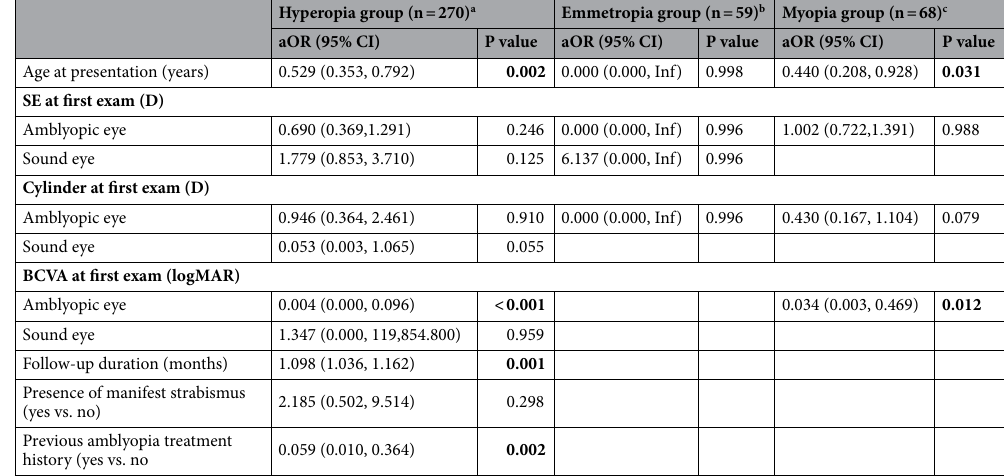
Table 3. Adjusted odds ratio values of factors influencing amblyopia treatment success during follow-up in hyperopia, emmetropia, and myopia groups. aOR adjusted odds ratio, CI confidence interval, D diopter, SE spherical equivalent, BCVA best-corrected visual acuity, Inf infinity. a Multivariate model of the hyperopia group started with age at presentation, SE of amblyopic eye, SE of sound eye, cylinder of amblyopic eye, cylinder of sound eye, logMAR BCVA of amblyopic eye, and logMAR BCVA of sound eye at first exam, follow-up duration, presence of manifest strabismus, and previous amblyopia treatment history. b Multivariate model of the emmetropia group started with age at presentation, SE of amblyopic eye, SE of sound eye, and cylinder of amblyopic eye. c Multivariate model of the myopia group started with age at presentation, SE of amblyopic eye, cylinder of amblyopic eye, and logMAR BCVA of the amblyopic eye at first